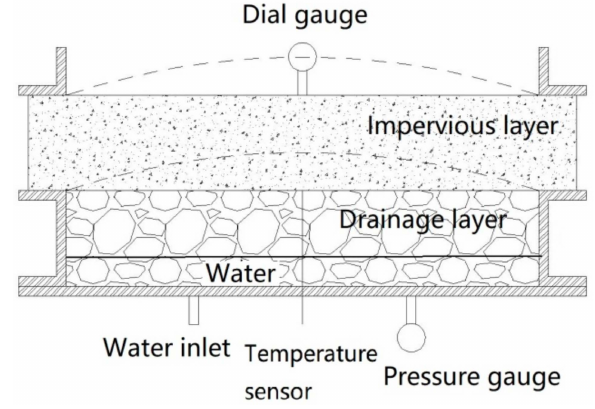
Figure 10. Model test